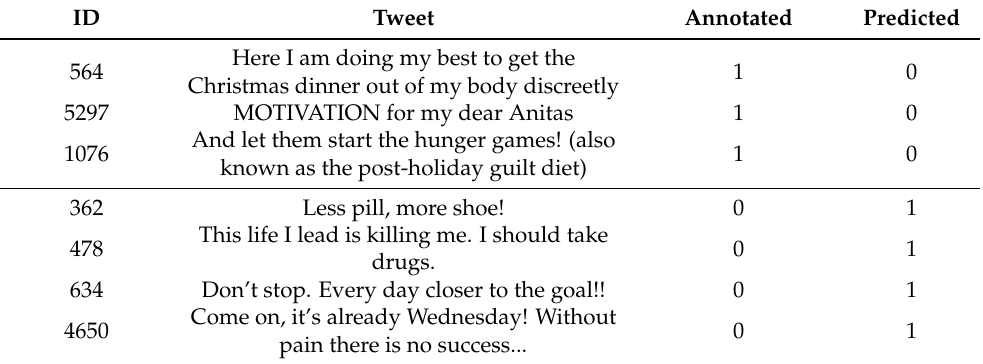
Table 5. Misclassified samples from SAD in